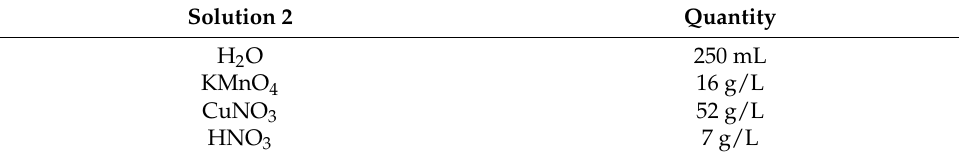
Table 3. Composition of blackening solution 2.